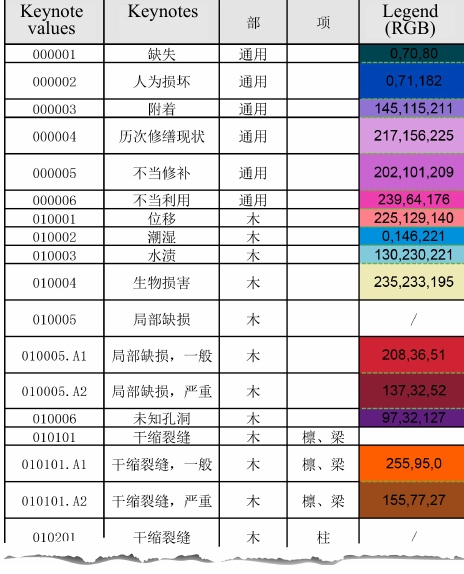
Figure 21 Defects Keynote Dictionary